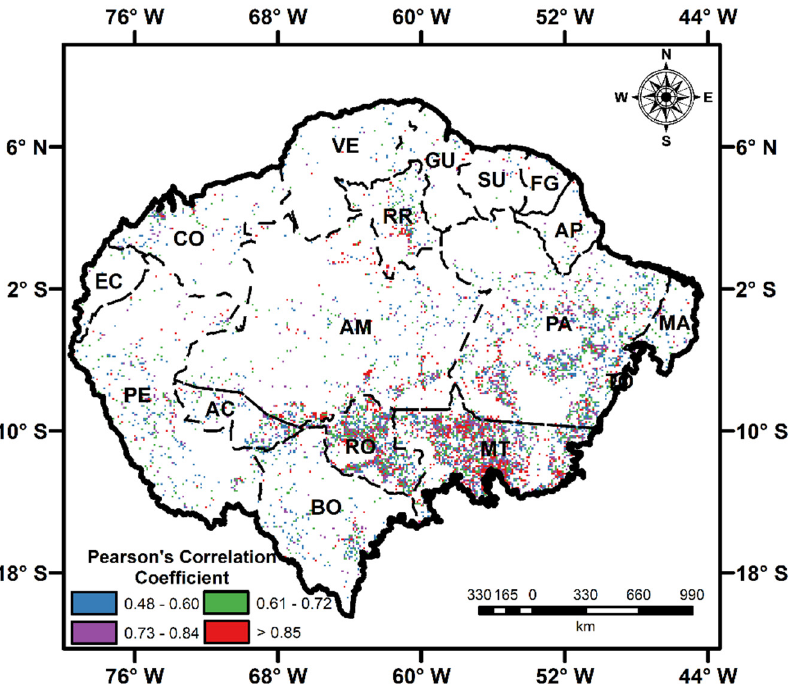
Figure 5. Pearson’s correlation coefficient between the pair of variables PM 2.5 emitted from biomass burning and deforestation in Amazonia. We have considered annual estimates during 2002–2018. Only statistically significant pixels are shown in this figure (18% of Amazonia). BO = Bolivia, CO = Colombia, EC = Ecuador, FG = French Guiana, GU = Guiana, PE = Peru, SU = Suriname, VE = Venezuela, AC = Acre, AM = Amazonas, AP = Amapá, MA = Maranhão, MT = Mato Grosso, RO = Rondônia, RR = Roraima, PA = Pará and TO = Tocantins.